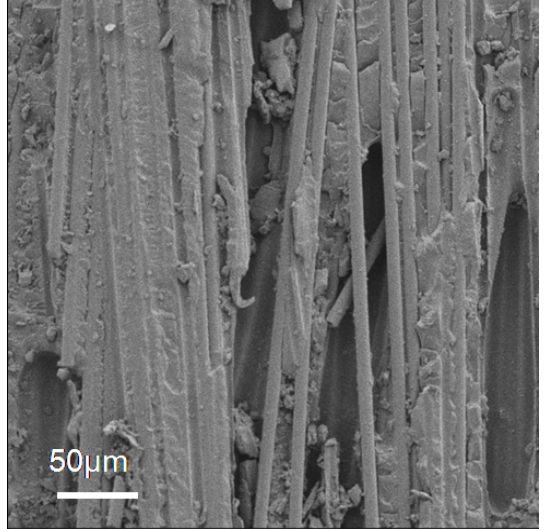
Figure 5. Scanning electron microscopy (SEM) fractography images of the reference sample after double cantilever beam (DCB) test showing a typical brittle interlaminar